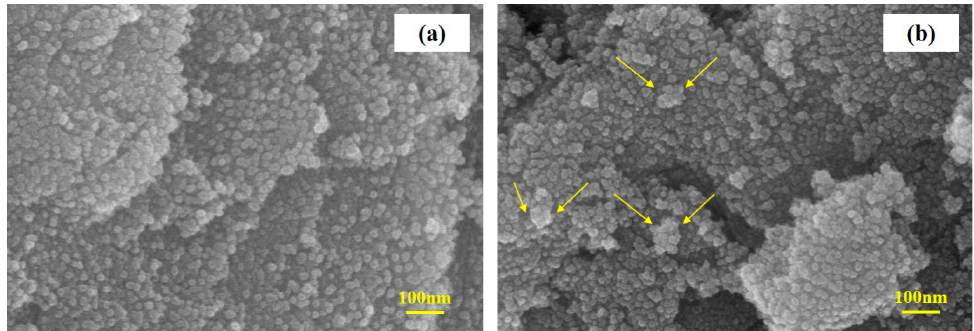
Figure 11. SEM images of the electrode ( a ) before and ( b ) after 200 cycles.